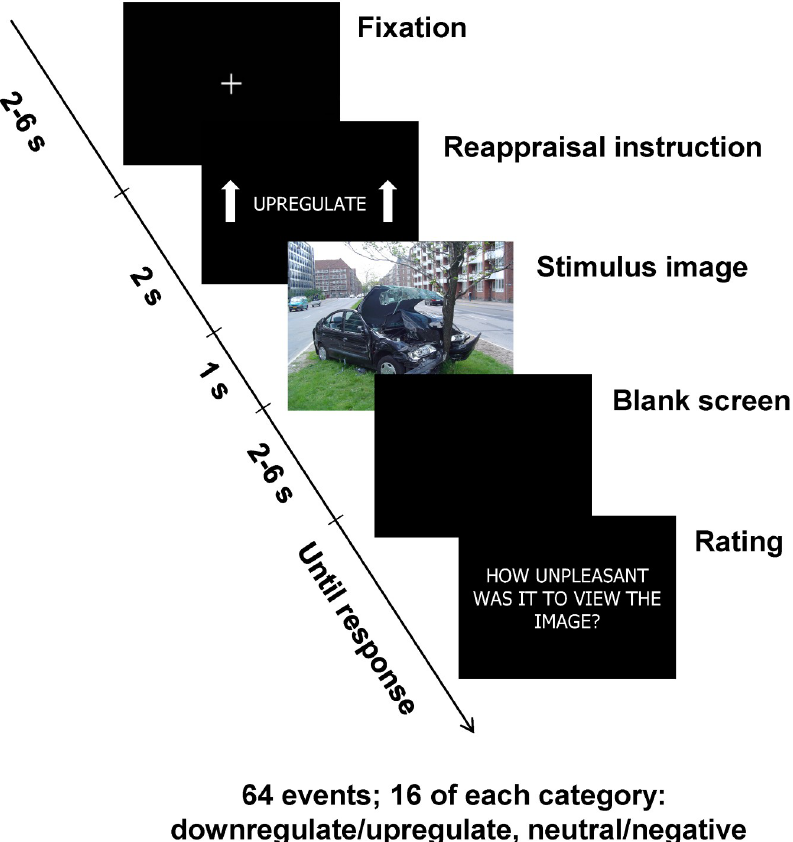
Fig 1. Experimental paradigm. The example stimulus image shown here was not part of the stimulus set; the image was created by Wikipedia contributor Thue and released on Wikimedia under a CC0 licence